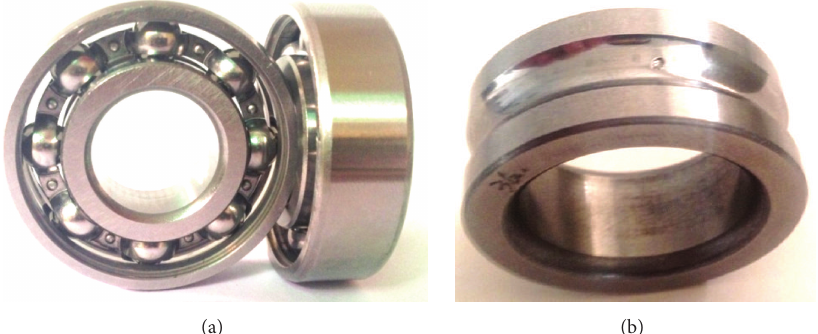
Figure 3: 6204 Bearing: (a) normal state and (b) inner ring pitting.